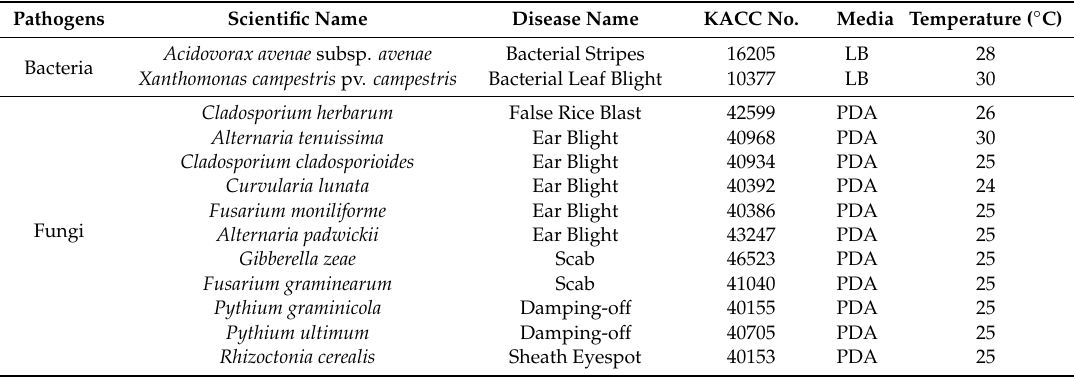
Table 1. List of bacteria and fungi obtained from the Rural Development Administration